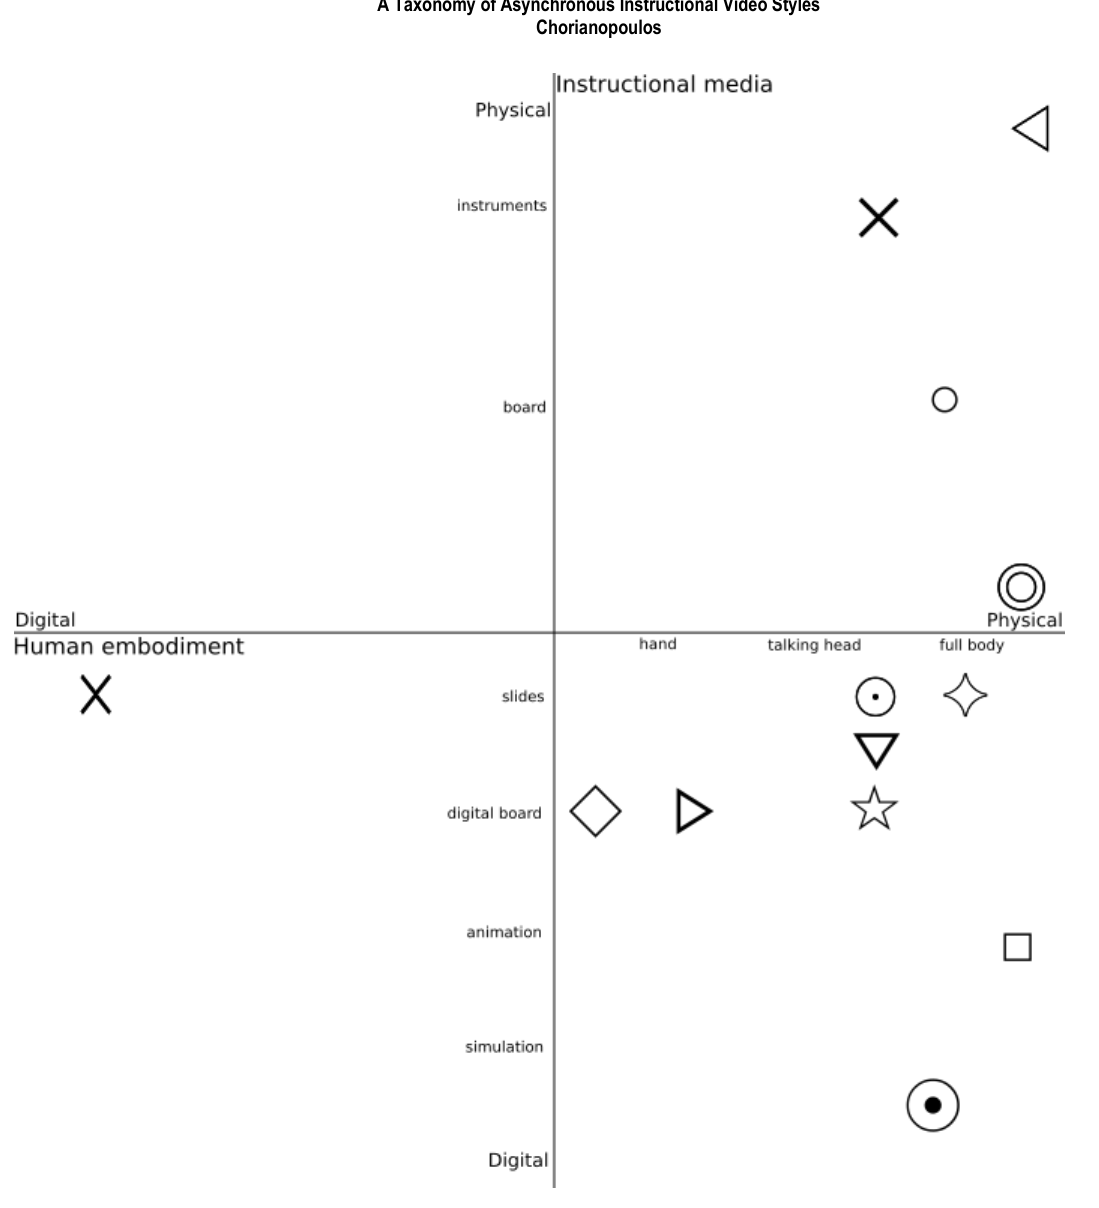
Figure 2. Taxonomy of instructional video styles into two